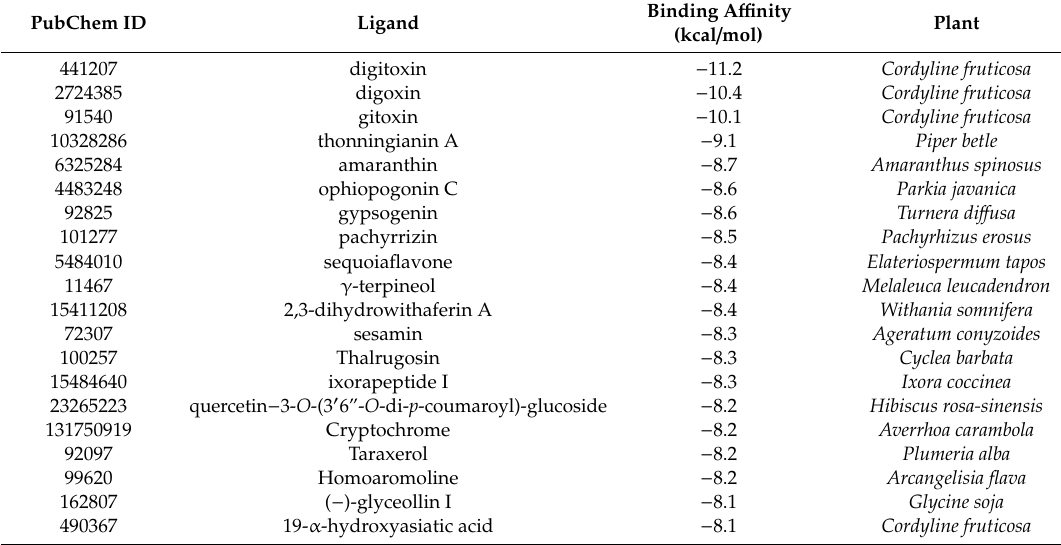
Table 1. The binding a ffi nity of the top 20 ligands from the herbal database with their corresponding source plant.